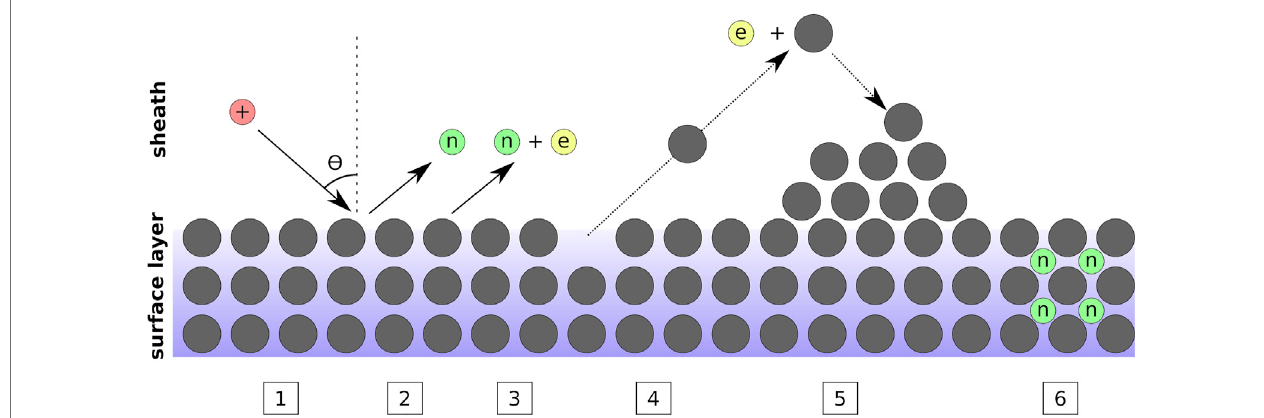
FIGURE5| Simpli fi eddiagramoftheplasma-surfaceinteractionphenomenamostrelevanttothestudyofHPSs.Theplasmasheathregionisdepictedatthetopof the diagram, while the top layers of the plasma-facing surface lattice are represented at its bottom, where the surface atoms are represented by solid circles. (1) represents the impacting ion, approaching the surface at an angle θ with respect to its normal, and with an energy E 0 . When the ion energy does not surpass the threshold energy for sputtering E 0 < E thr , the ion may become neutralized by a surface electron releasing a re fl ected neutral as shown in (2). In some cases, an additional electron may be released [secondary or Auger emission, (3)]. When E 0 > E thr , collisional cascades within the top surface lattice are suf fi cient to expel a surface atom and sputtering occurs (4). The sputtered surface atoms might become ionized as they traverse the sheath, in which case they will be accelerated by the sheath potentialbacktowardsthesurfaceand redeposition ofmaterialmayoccur(5).Iftheionimpactenergyissuf fi cientlylarge, E 0 ≫ E thr ,theionsmaybecomeneutralizedand implanted within the surface lattice (6).